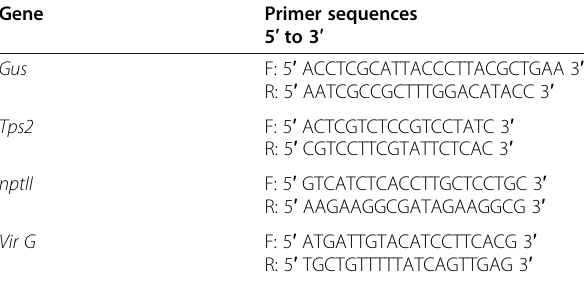
Table 2 Nucleotide sequences of primers used in PCR Gene Primer sequences 5 ′ to 3